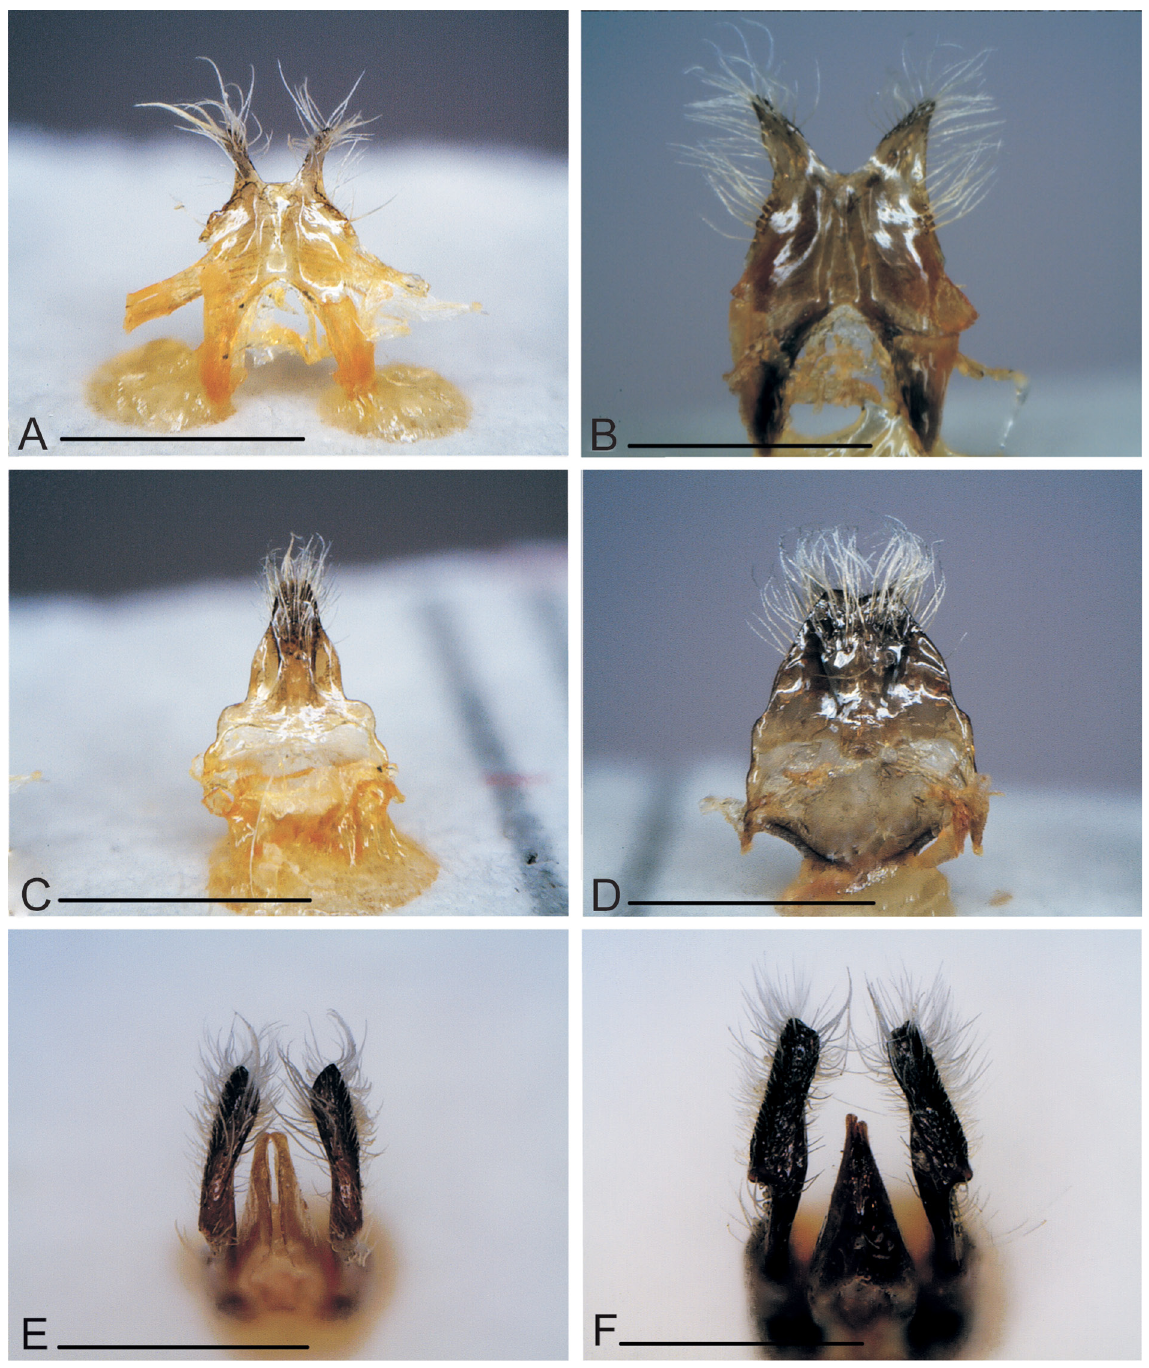
Fig. 3. Fidelia spp., ♂♂. A , C , E . Fidelia whiteheadi Litman & Kuhlmann sp. nov. (paratype). B , D